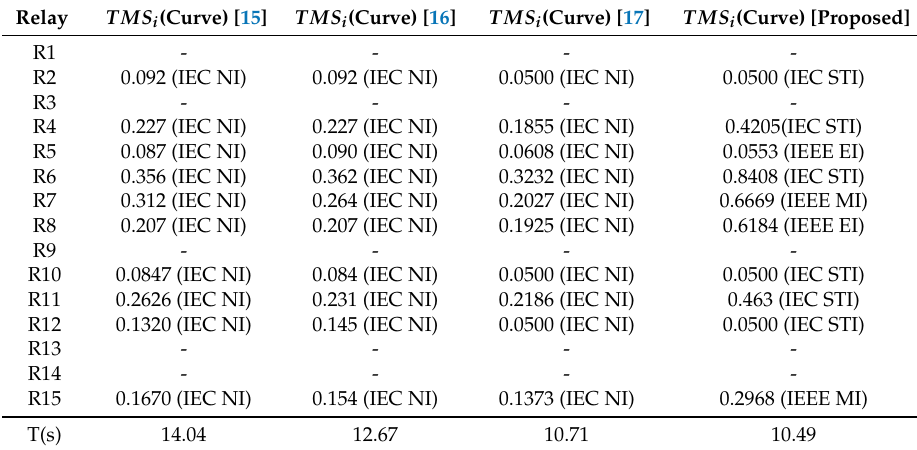
Table 8. Coordination parameters for OM3.